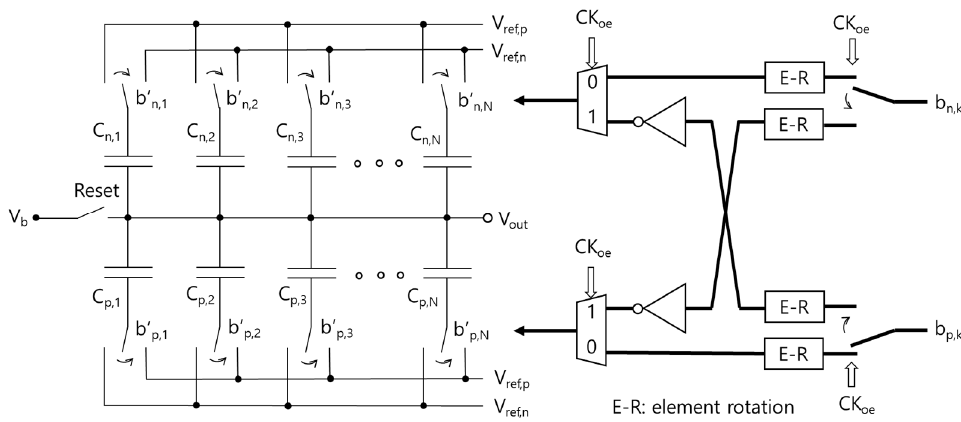
Figure 7. Simplified schematic of the proposed C-DAC.